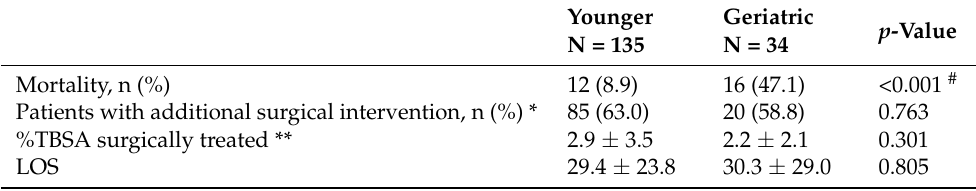
Table 2. Clinical